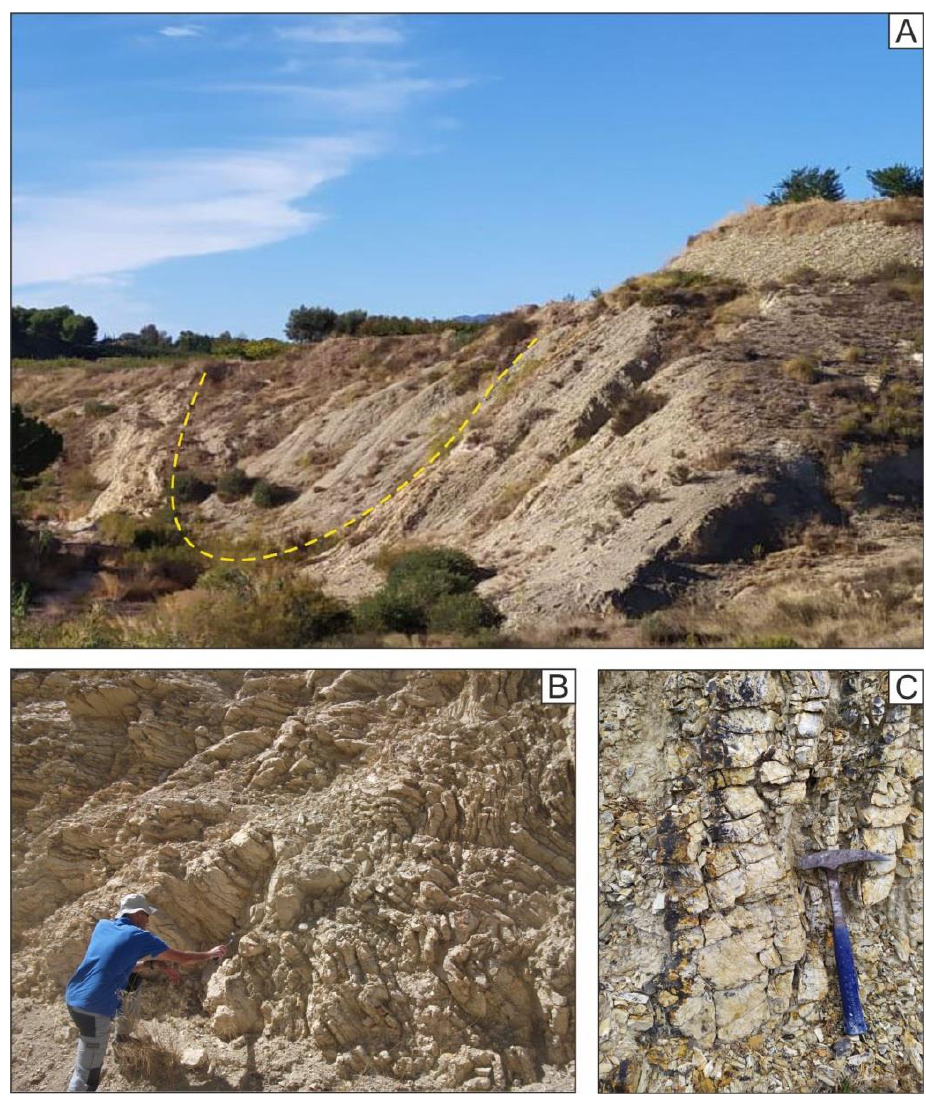
Figure 12. Site 8: The Burdigalian El Niño Fm in the Mula area. ( A ) Panoramic view of the syncline fold in the siliceous marls and silexites. ( B ) Detail of the strongly folded siliceous marls and silexites. ( C ) Detail of the silexites.